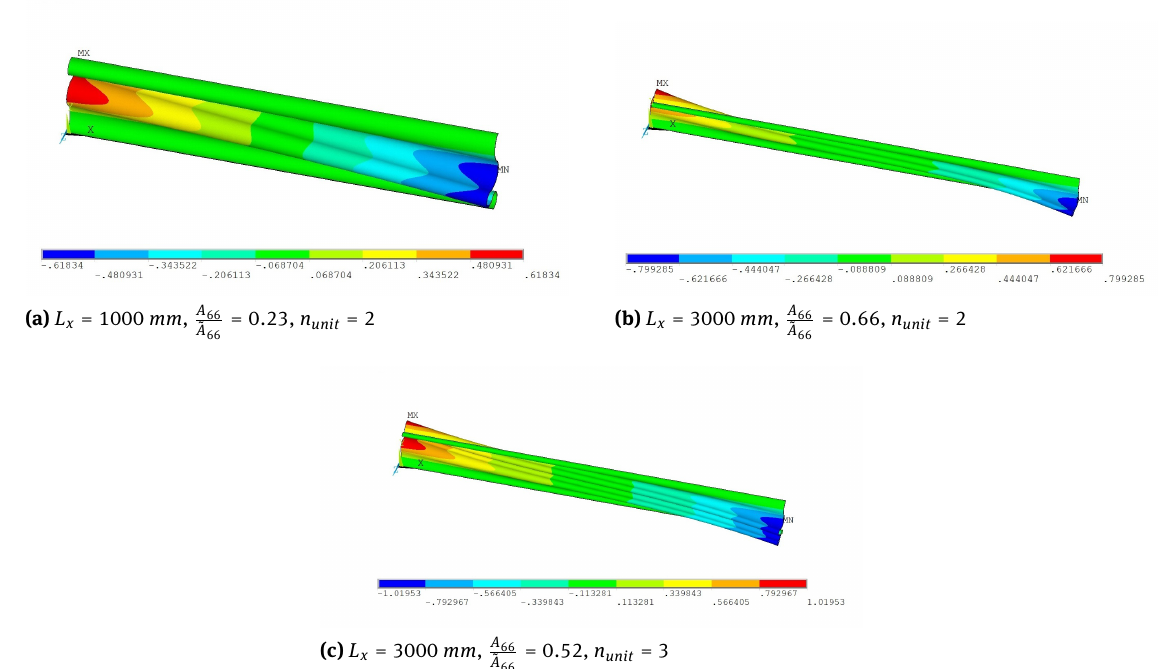
Figure 24: Scaled deformation of different corrugated laminates with CFRP [90 4 ] lay-up and 1 mm thickness subjected to shearing. The color bar indicates the deformation in y-direction (in-plane